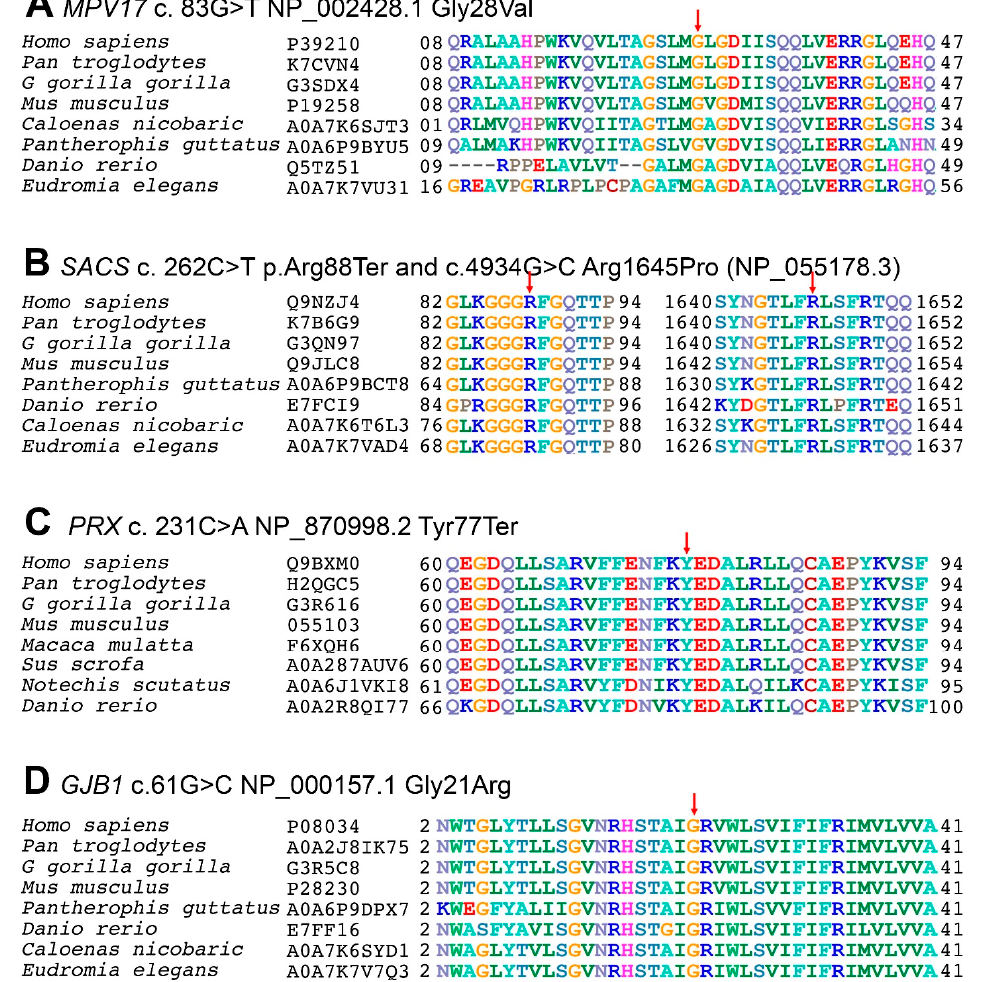
online prediction tools.